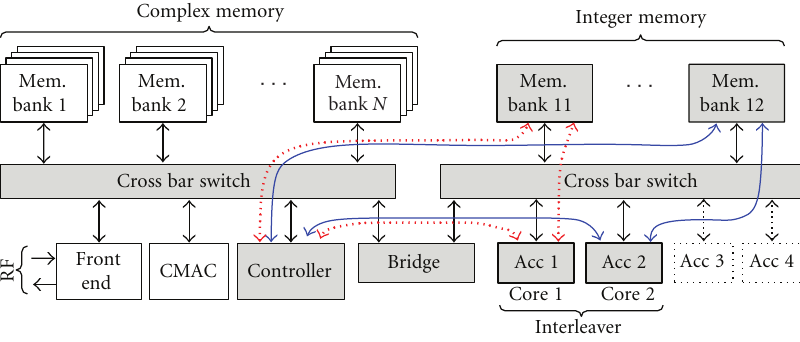
Figure 16: Integration of interleaver core with baseband processor.